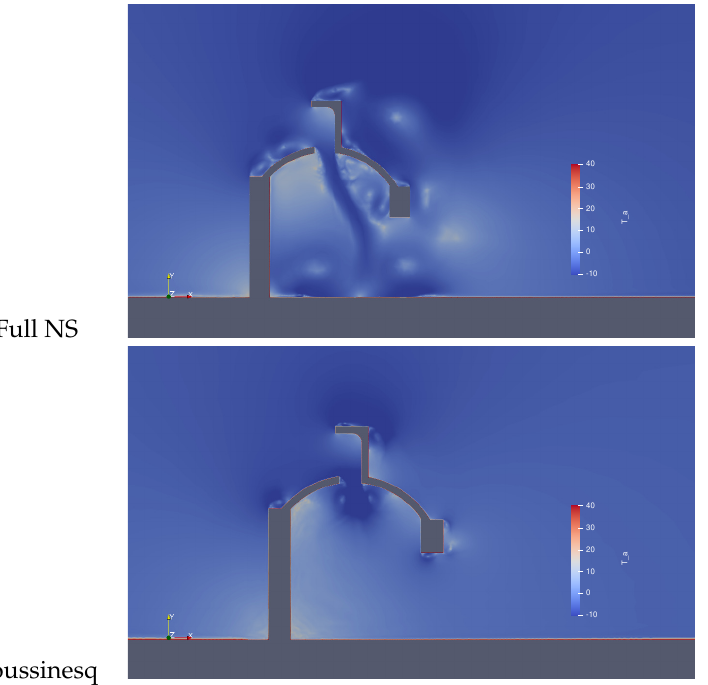
Figure 24. Wind tower 2. Apparent temperature field obtained by the full NS and the Boussinesq model with U ∞ = 5